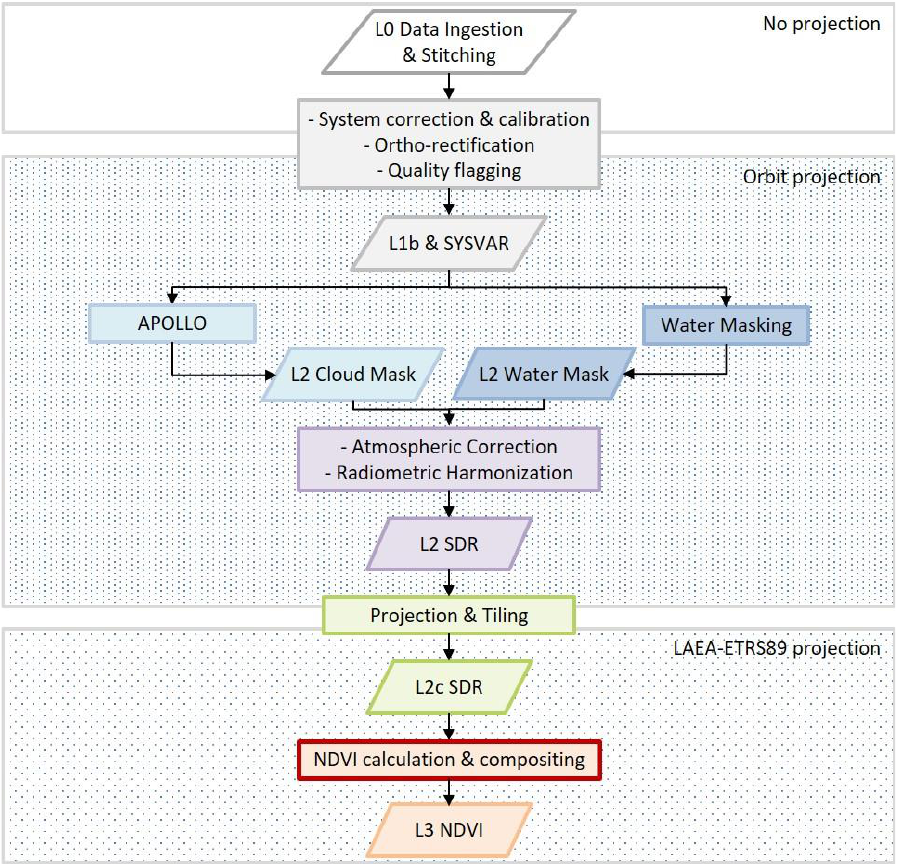
Figure 2. TIMELINE Processing chain from L0 raw data to NDVI L3.